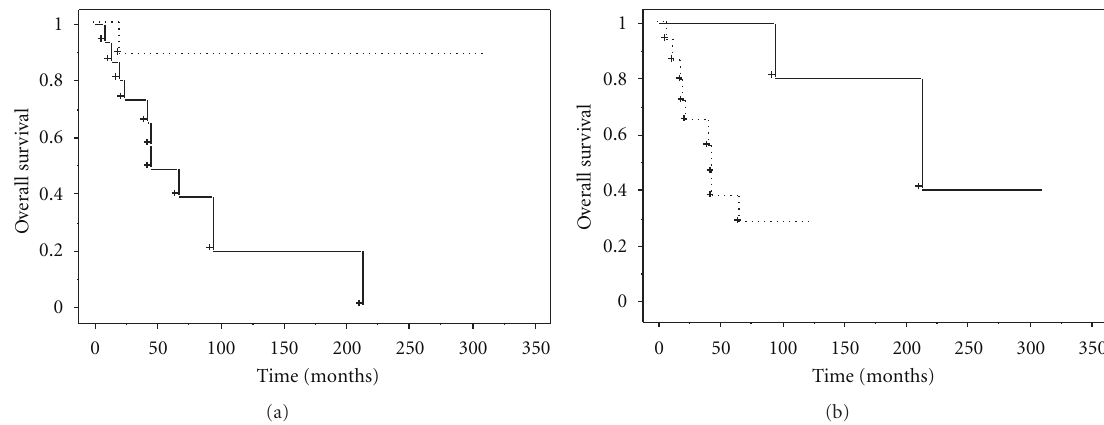
Figure 2: Kaplan-Meier plots showing overall survival stratified by (a) tumor size ( > 5cm: solid line, ≤ 5cm: dashed line) and (b) AJCC stage (stage IIA, III: solid line, stage IV: dashed line).